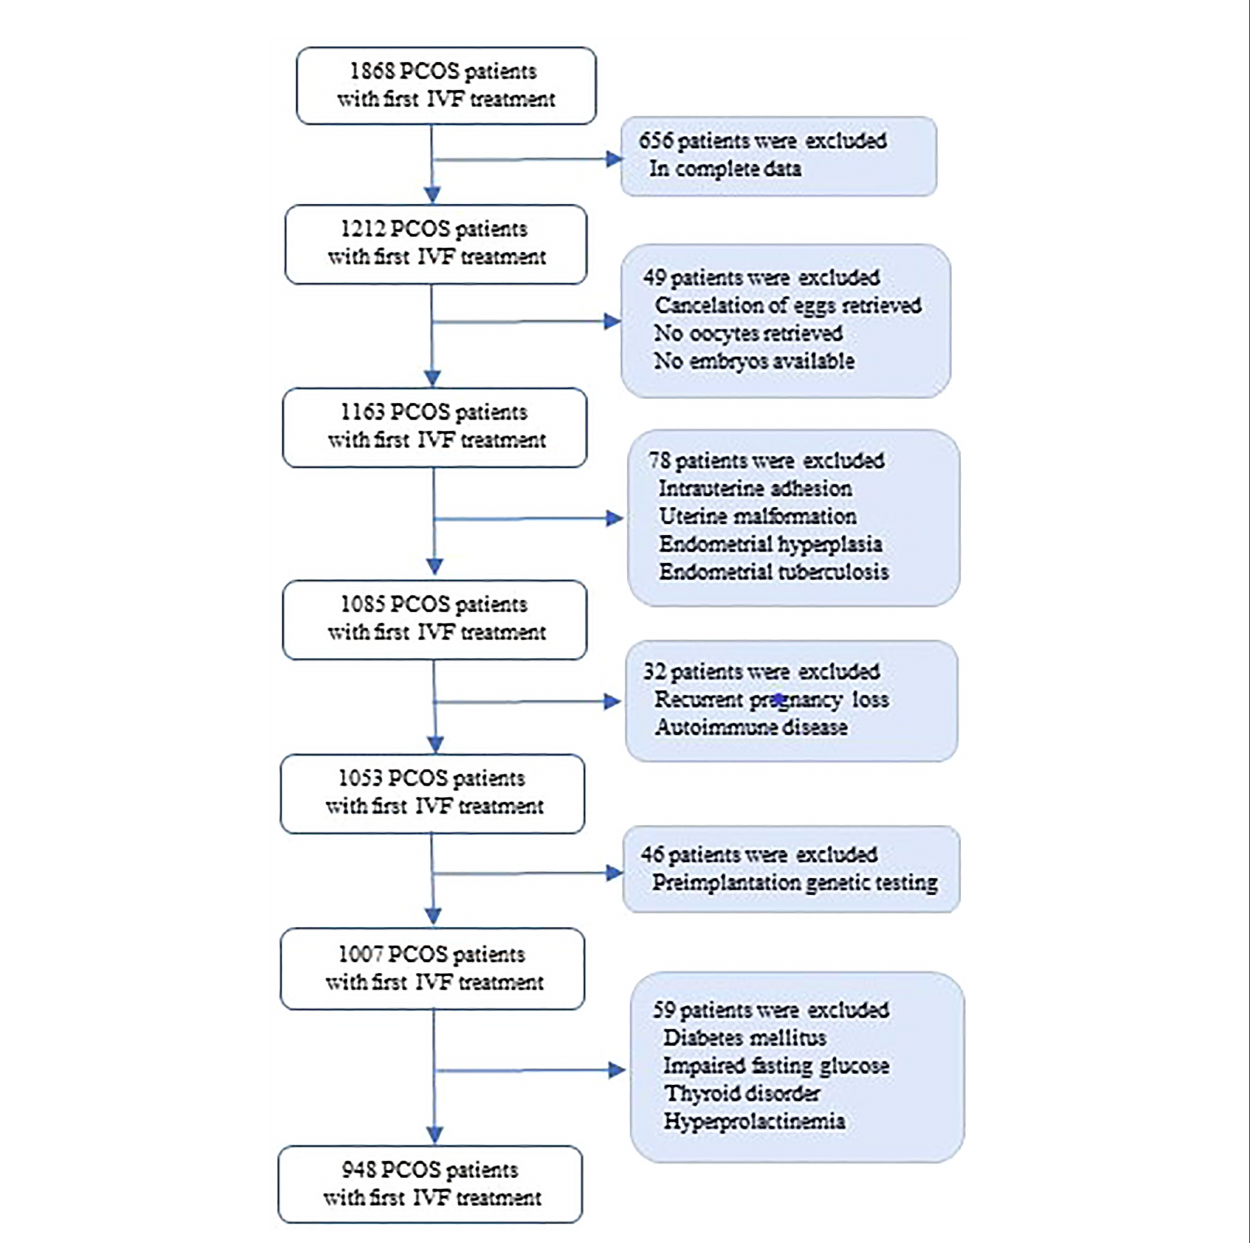
FIGURE 1 | Flow chart of patients ’ selection and